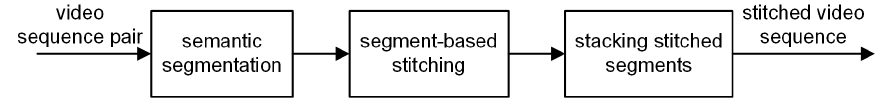
Figure 1. Proposed semantic segmentation-based video